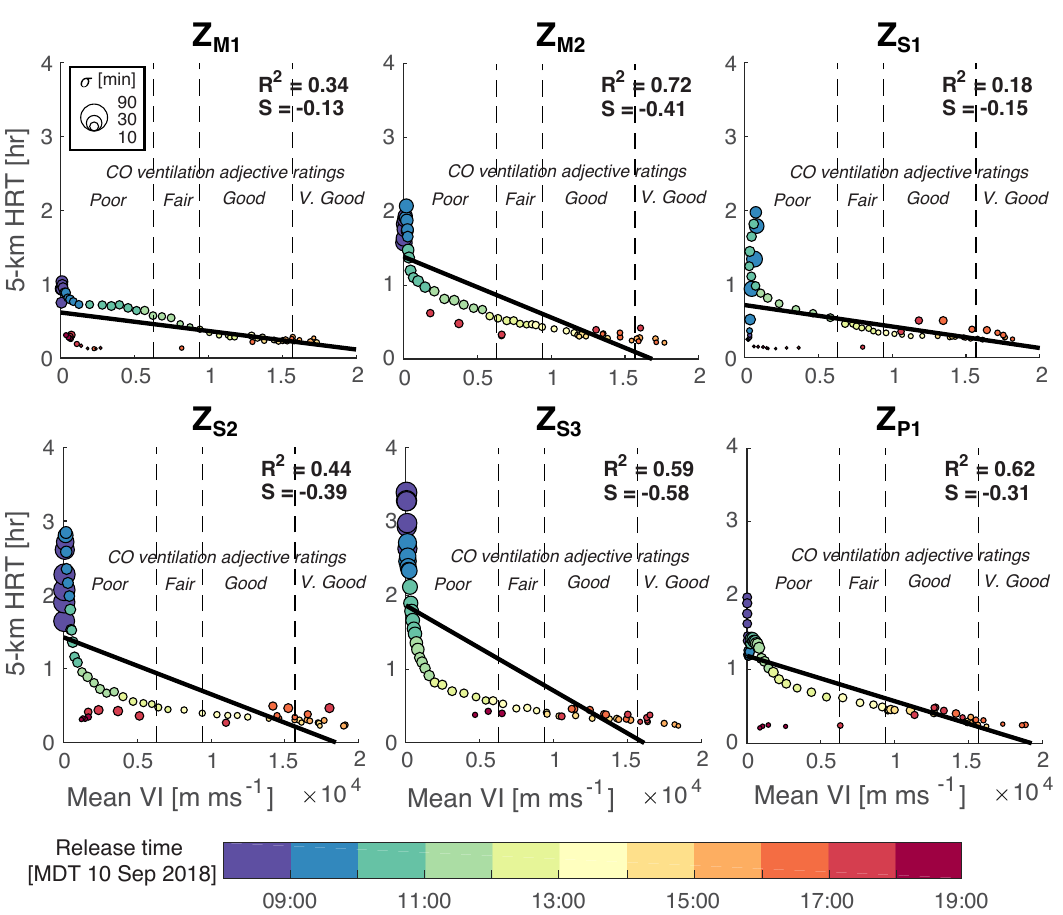
Figure 9. Scatterplots of 10-min-mean, zone-averaged ventilation index (VI) vs. ensemble-mean HRT, for each analysis zone. The size of each circle is proportional to the standard deviation of HRT within that time bin (see legend in top-left panel), and the marker color corresponds to the one-hour release time block indicated in the color bar below the figure. The thick black line is the linear regression, S is the normalized slope, computed as the slope divided by the plot aspect ratio [(y max − y min )/(x max − x min )], and R 2 is the coefficient of determination. State of Colorado VI adjective ratings are provided for reference only (adjective ratings developed by the state of Colorado, with little documentation of their